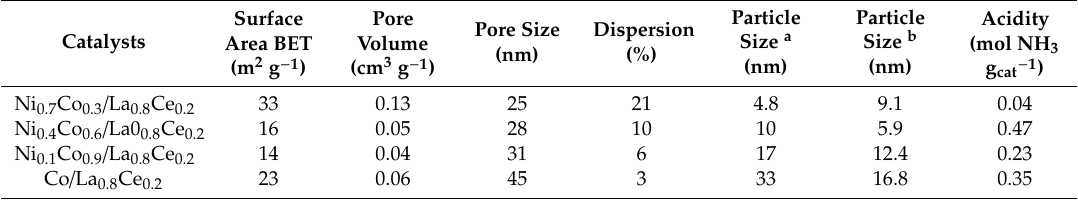
Table 1. Structural parameters of supports and Ni 1-x Co x / La 0.8 Ce 0.2